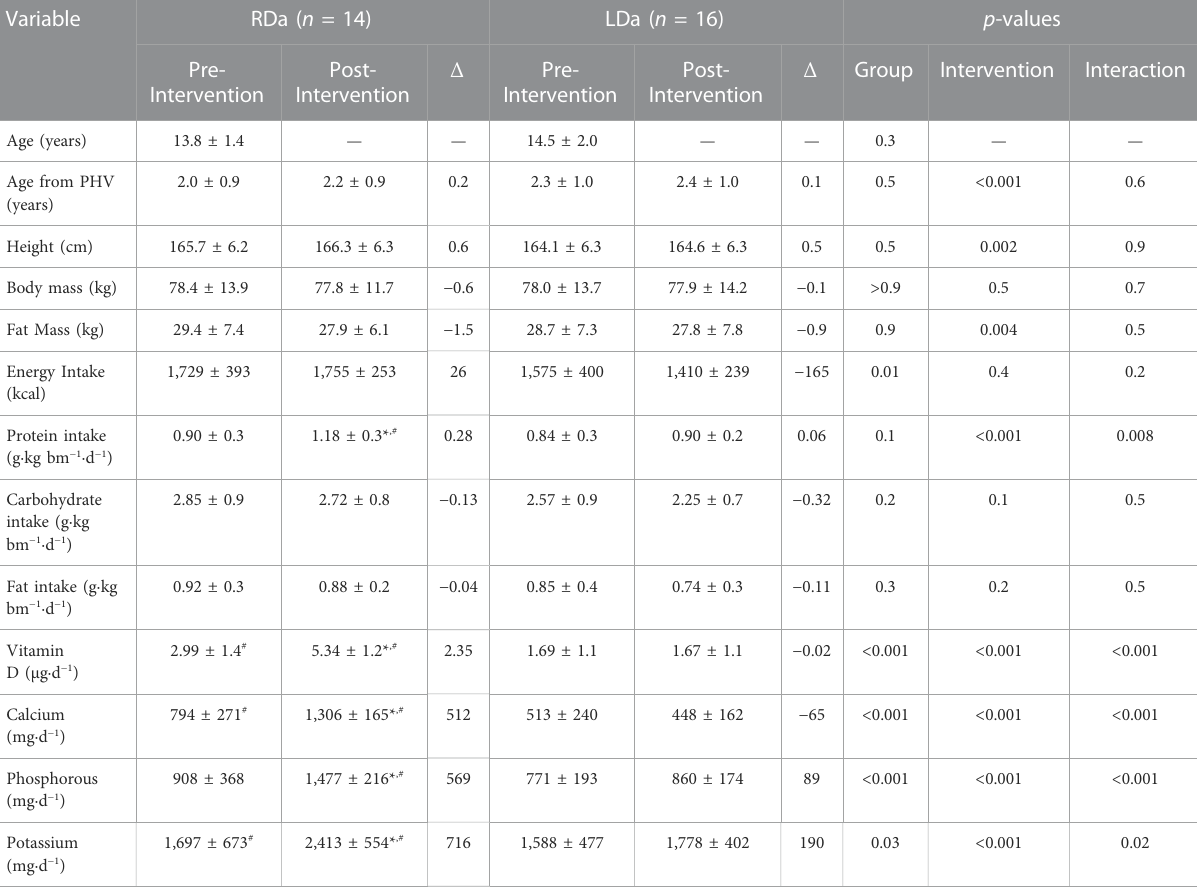
TABLE 1 Age, anthropometric, body composition, andnutrient intake atpre- and post-intervention for the higher dairy intake (RDa) and the low dairy intake (LDa) groups.